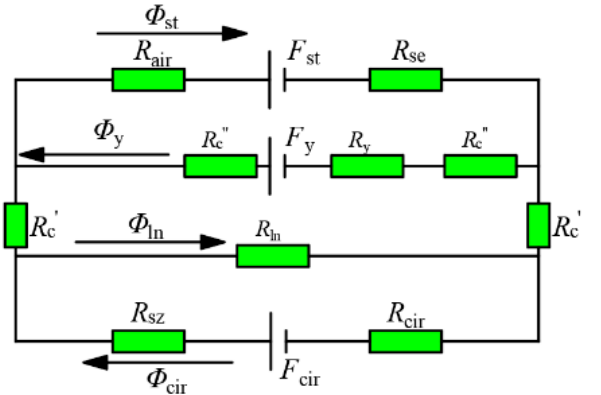
Figure 5. Equivalent magnetic circuit diagram of claw pole generator with inter-pole PM. Φ st is the magnetic flux through the air gap, Φ lm is the external flux leakage of the rotor, Φ ln is the internal flux leakage of the rotor, Φ cir is the magnetic flux generated by a toroidal PM, Φ y is the magnetic flux generated by the PM between the poles; F st is the stator magnetomotive force, F cir is the magnetomotive force generated by a toroidal PM, F y is the magnetomotive force generated by the PM between the poles; R air is the air gap magnetoresistance, R se is the stator magnetoresistance, R lm is the external leakage mag- netoresistance of the rotor, R c is the rotor tooth magnetoresistance, R y is the magnetore- sistance of the PM between the poles, R ln is the leakage magnetoresistance inside the ro- tor, R sz is the magnetoresistance of the claw rotor except for the tooth part, R cir is the R c ″ is the tangential magnetoresistance of the rotor teeth.